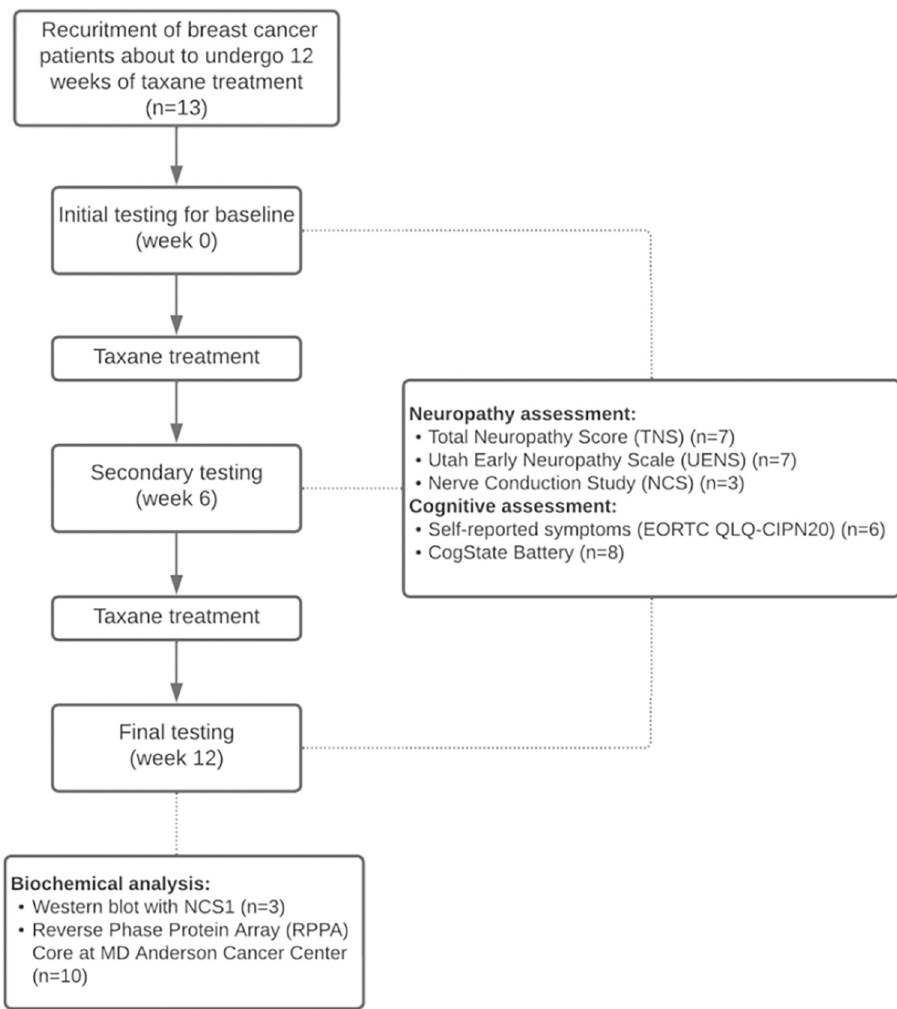
Fig 1. Schematic of study